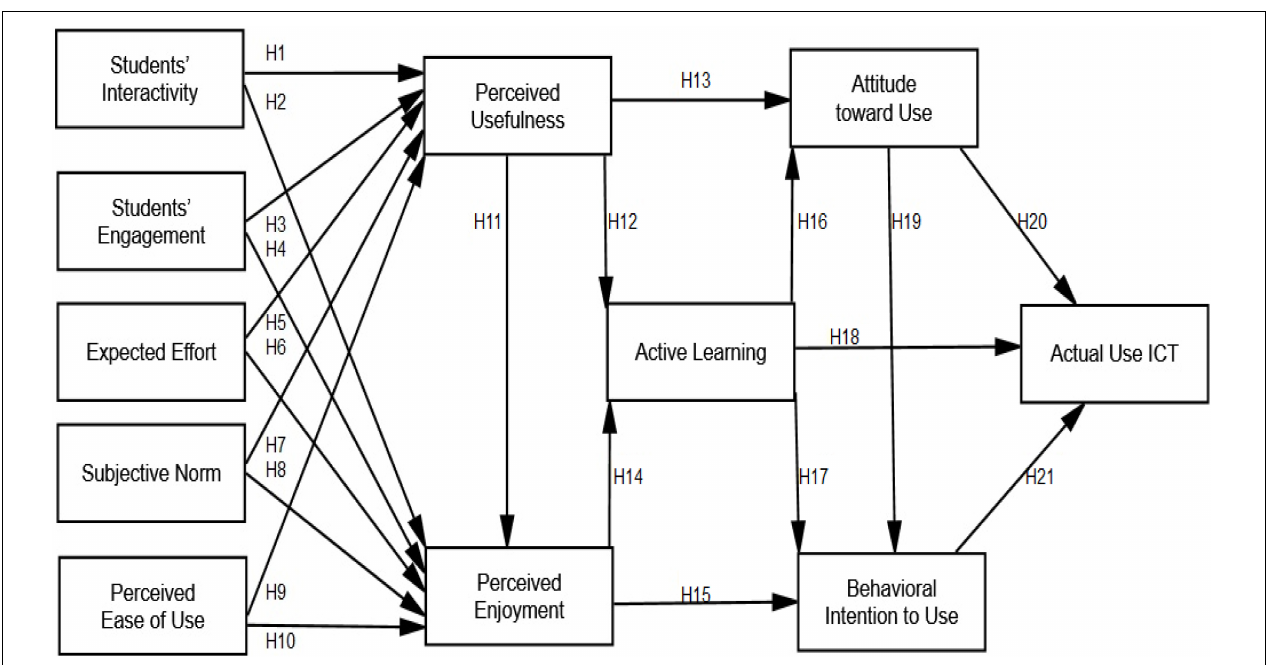
FIGURE 1 | Research model and